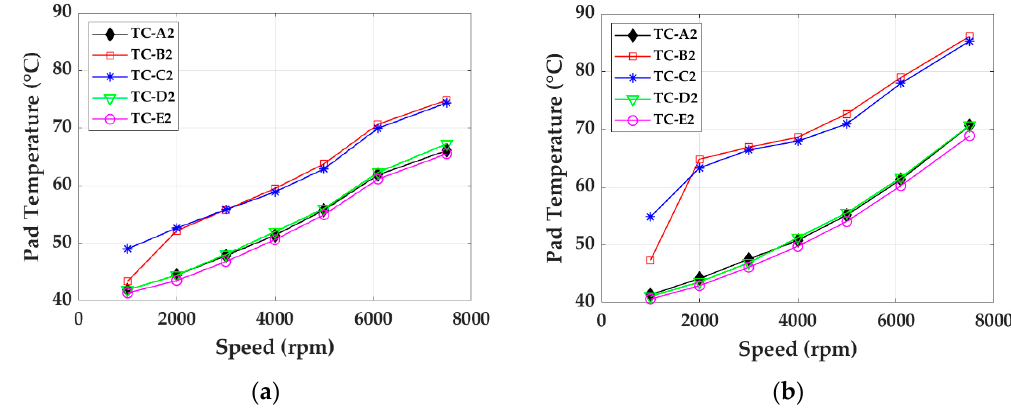
( a ) ( b ) Figure 16. Direct Lube Rocker Pivot bearing pad temperatures @ 75% of pad arc: ( a ) 0.8 MPa, ( b ) 1.7 MPa.